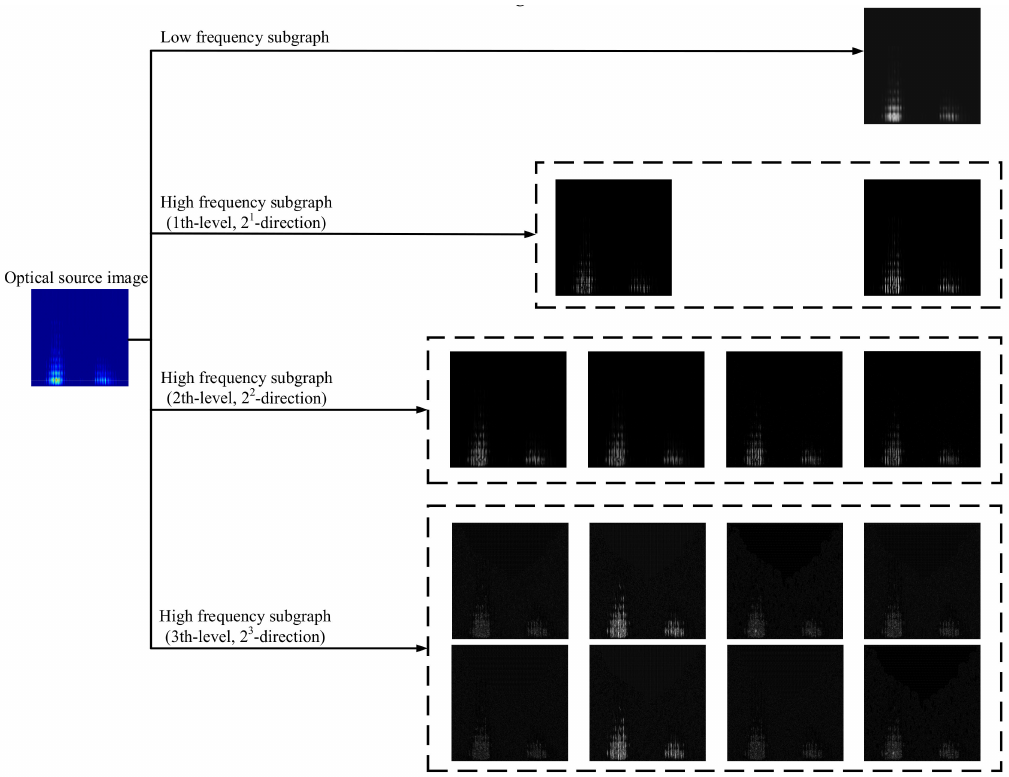
Figure 12. NSCT decomposition of the optical PD pattern.